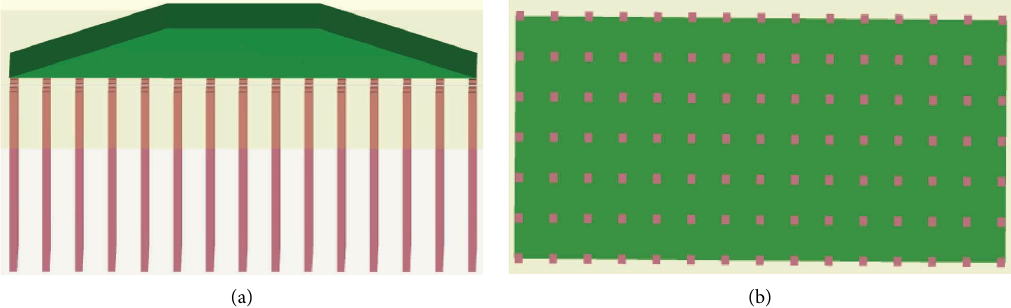
Figure 5: (a) Installation of drains in clay soil. (b) Arrangement of drains in square pattern.